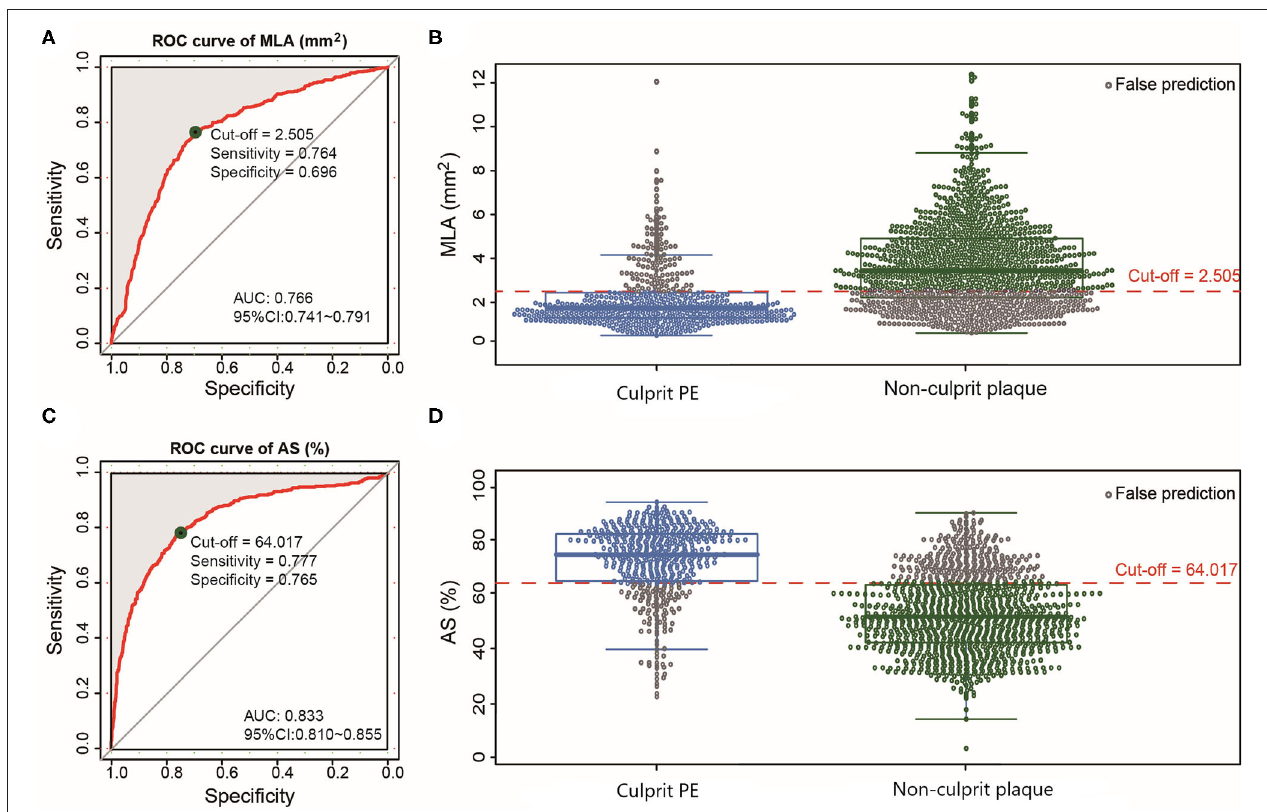
FIGURE 3 | ROC curves of MLA and AS for differentiating culprit PE from non-culprit plaques. The optimal cut-off value of MLA was 2.51 mm 2 (AUC = 0.766) (A) and the prediction probability was 76.4% for culprit PE (B) . The optimal cut-off value of AS was 64.02% (AUC = 0.833) (C) and the prediction probability was 77.7% for culprit PE (D) . AS, area stenosis; AUC, area under the curve; CI, confidence interval; MLA, minimal lumen area; PE, plaque erosion; ROC, receiver operating